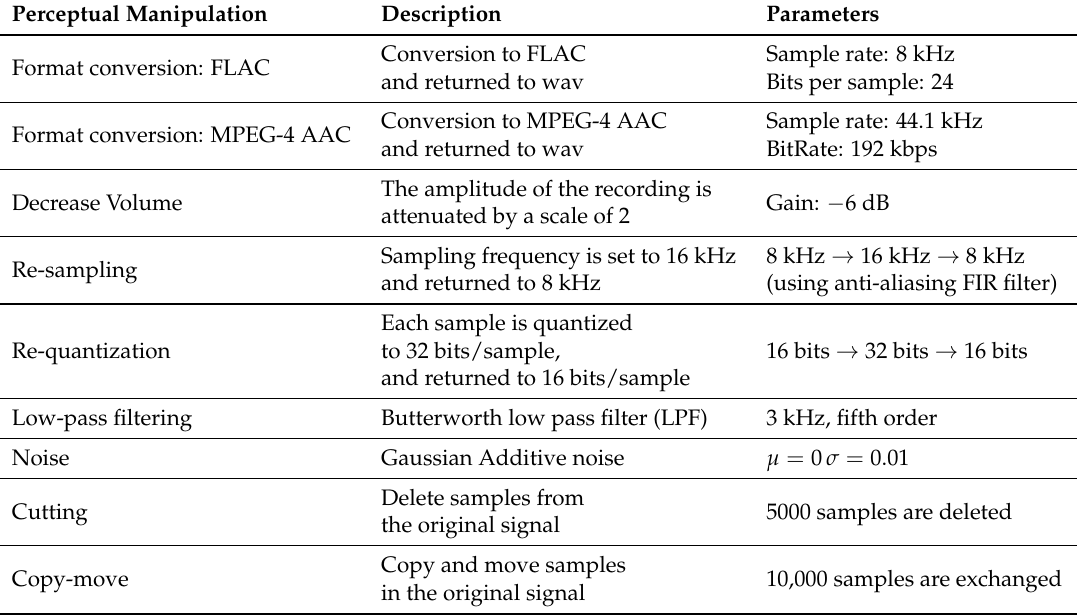
Table 4. Manipulations used to test perceptual and non-perceptual